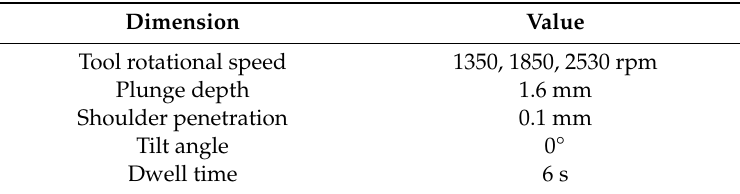
Table 4. Process parameters.